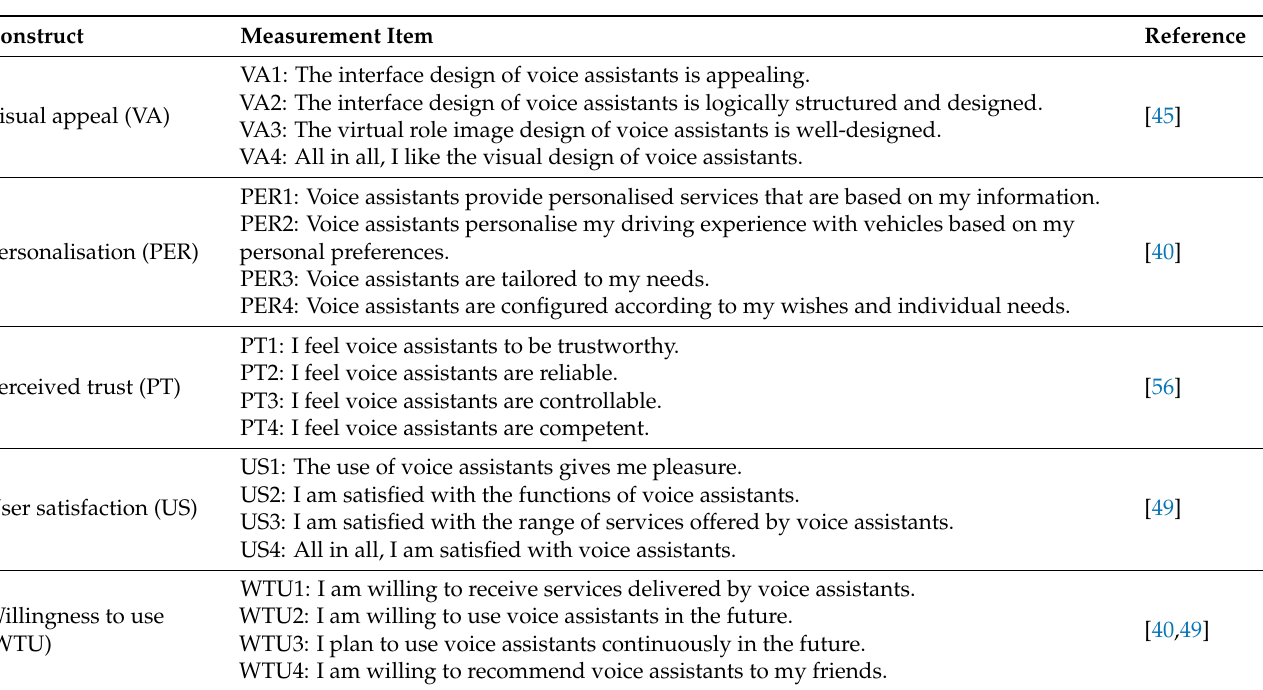
Table 1. Cont. Measurement